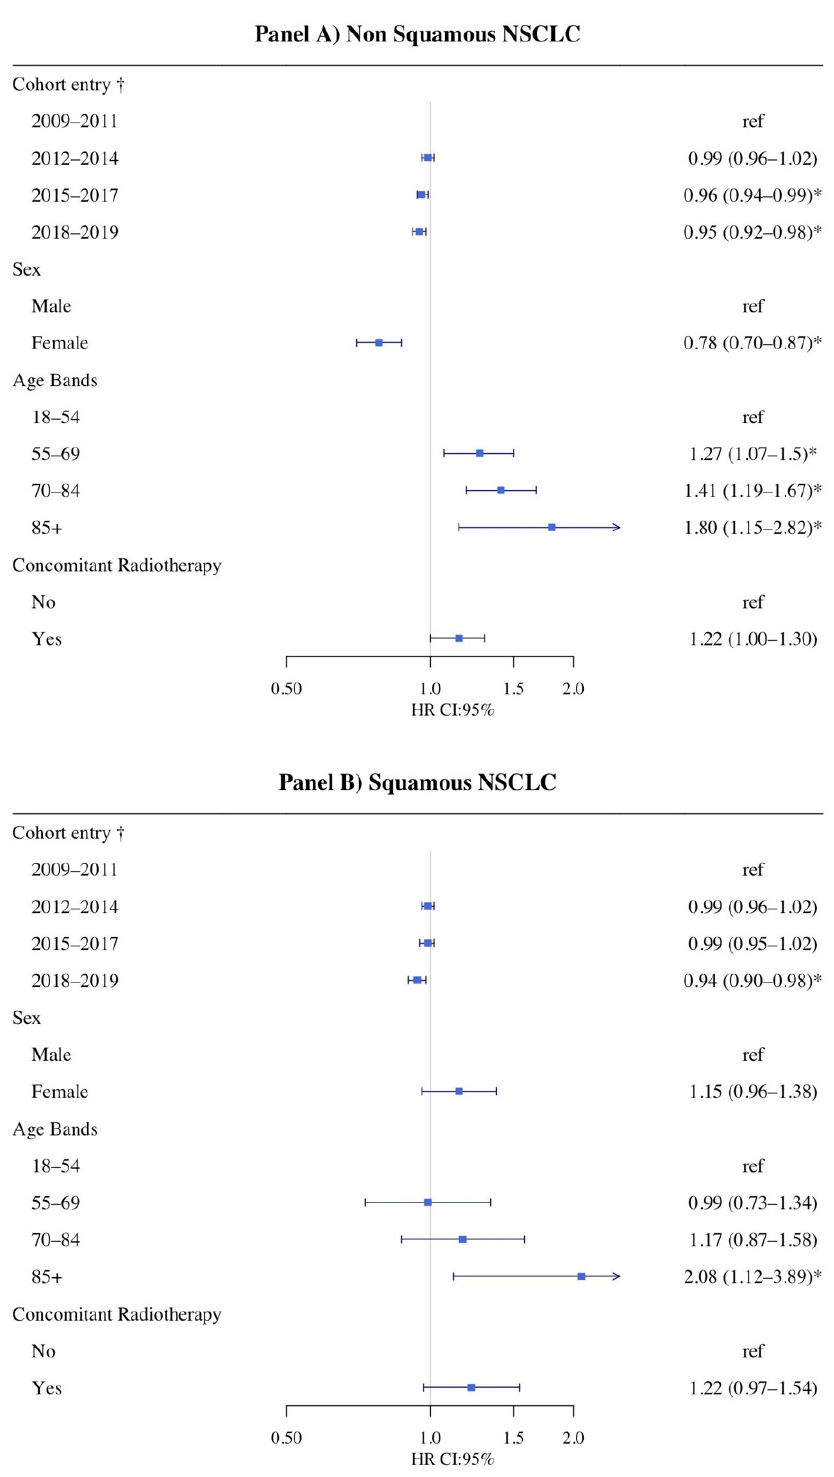
Figure 5. Multivariate cox proportional hazard models for survival; panel ( A ): non-squamous patients; panel ( B ): squamous patients; * p < 0.05; † time-dependent covariates.